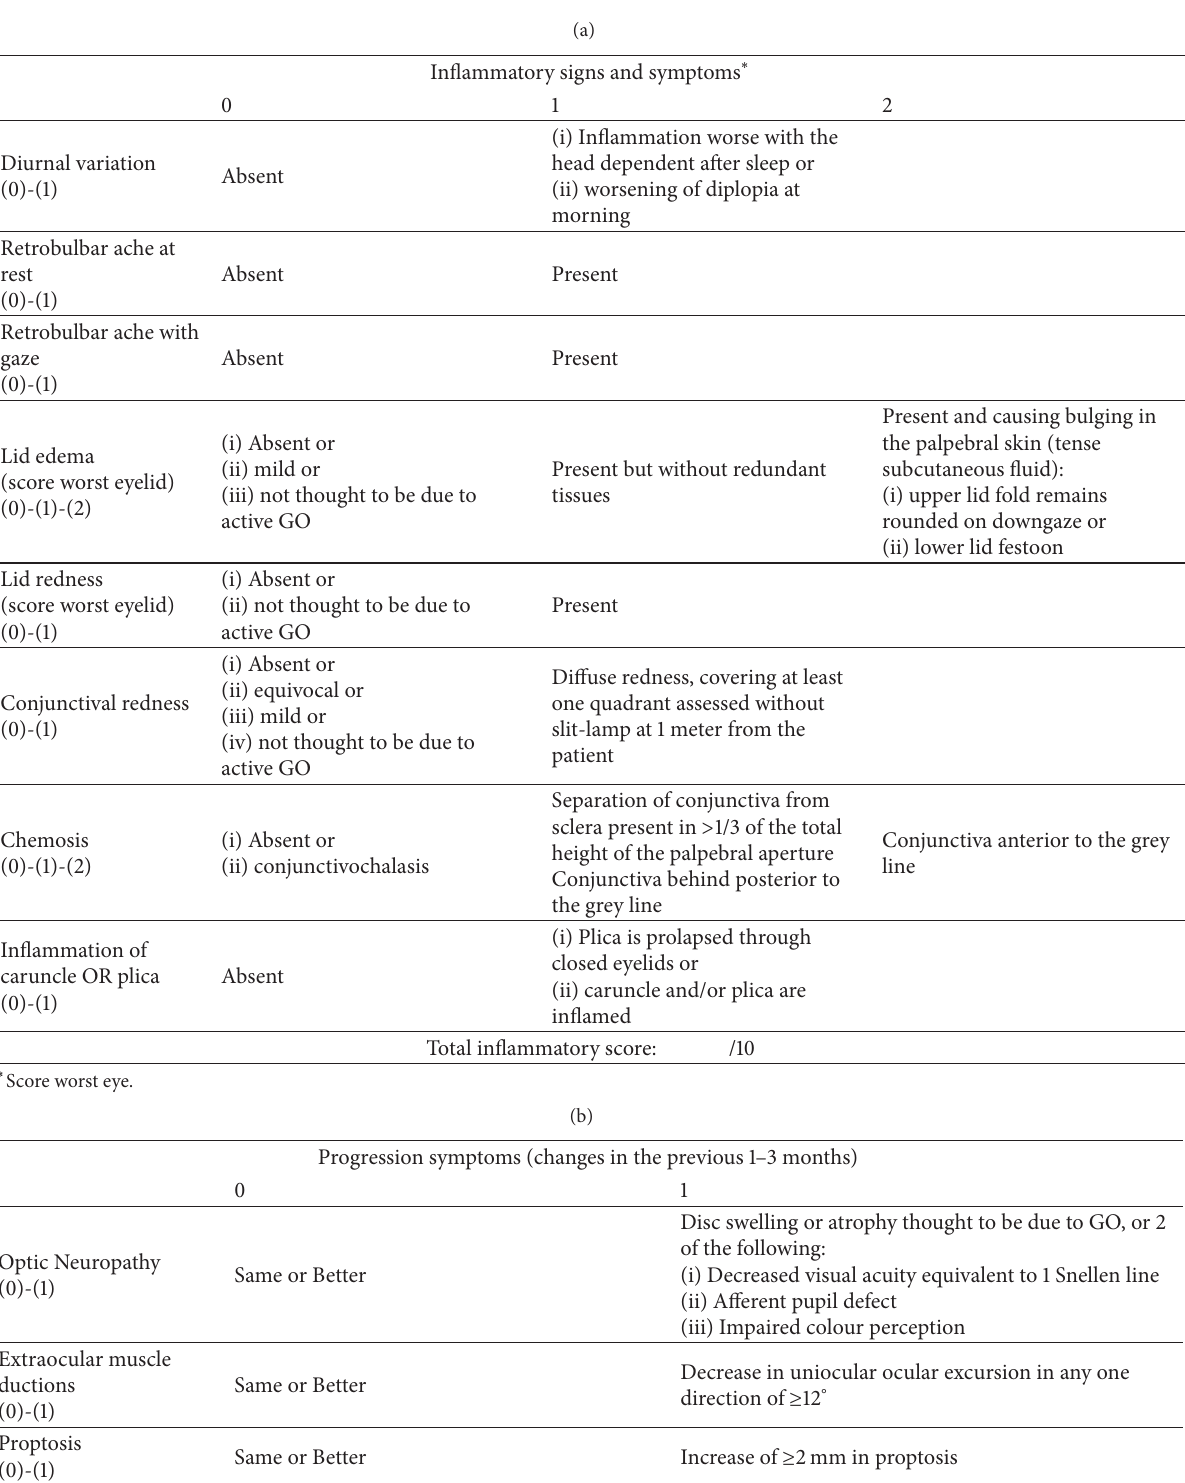
Table 5: Proposed “GO activity assessment checklist” based on VISA and EUGOGO classifications. Any change in the progression symptoms or inflammatory score higher than 5 would warrant more aggressive